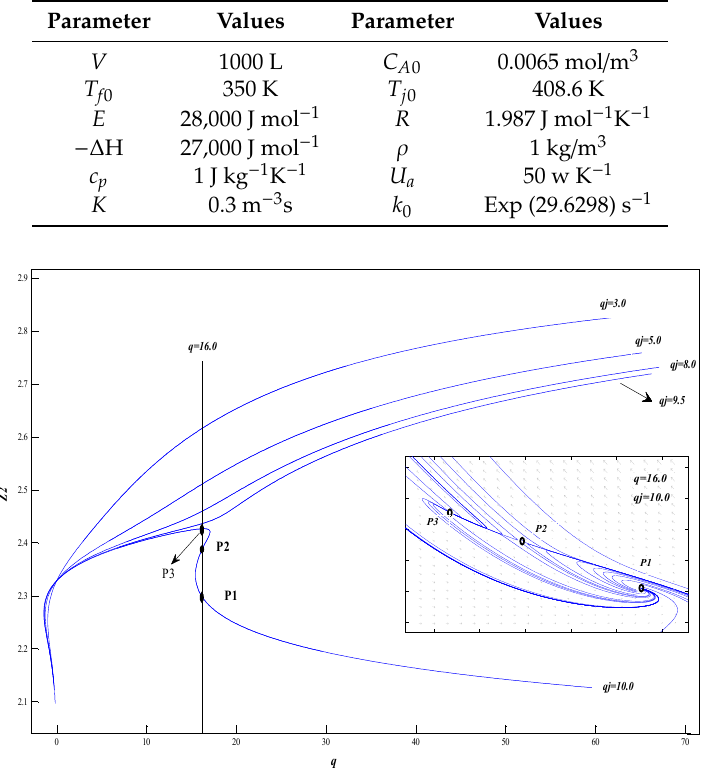
Figure 2. The steady state curves with input as the continuation parameter.